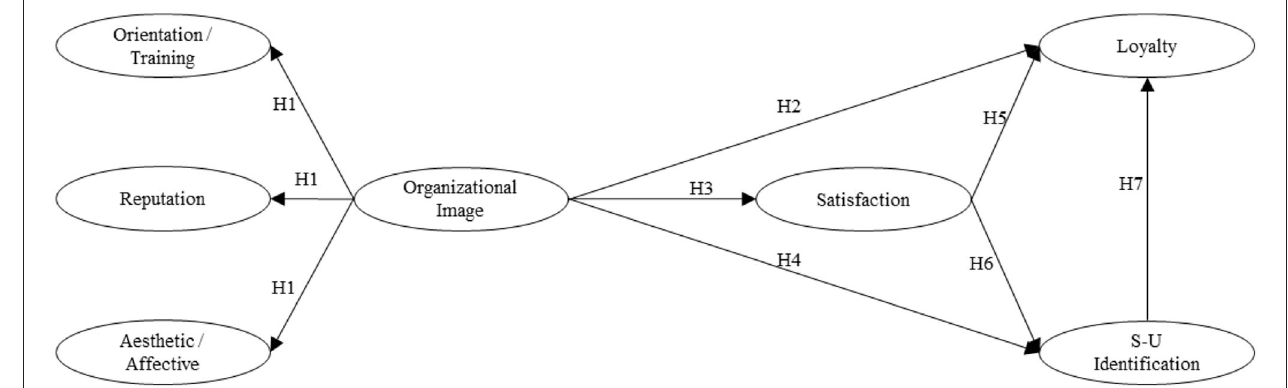
FIGURE 1 | Theoretical model and hypothesis. Source: Authors’ own